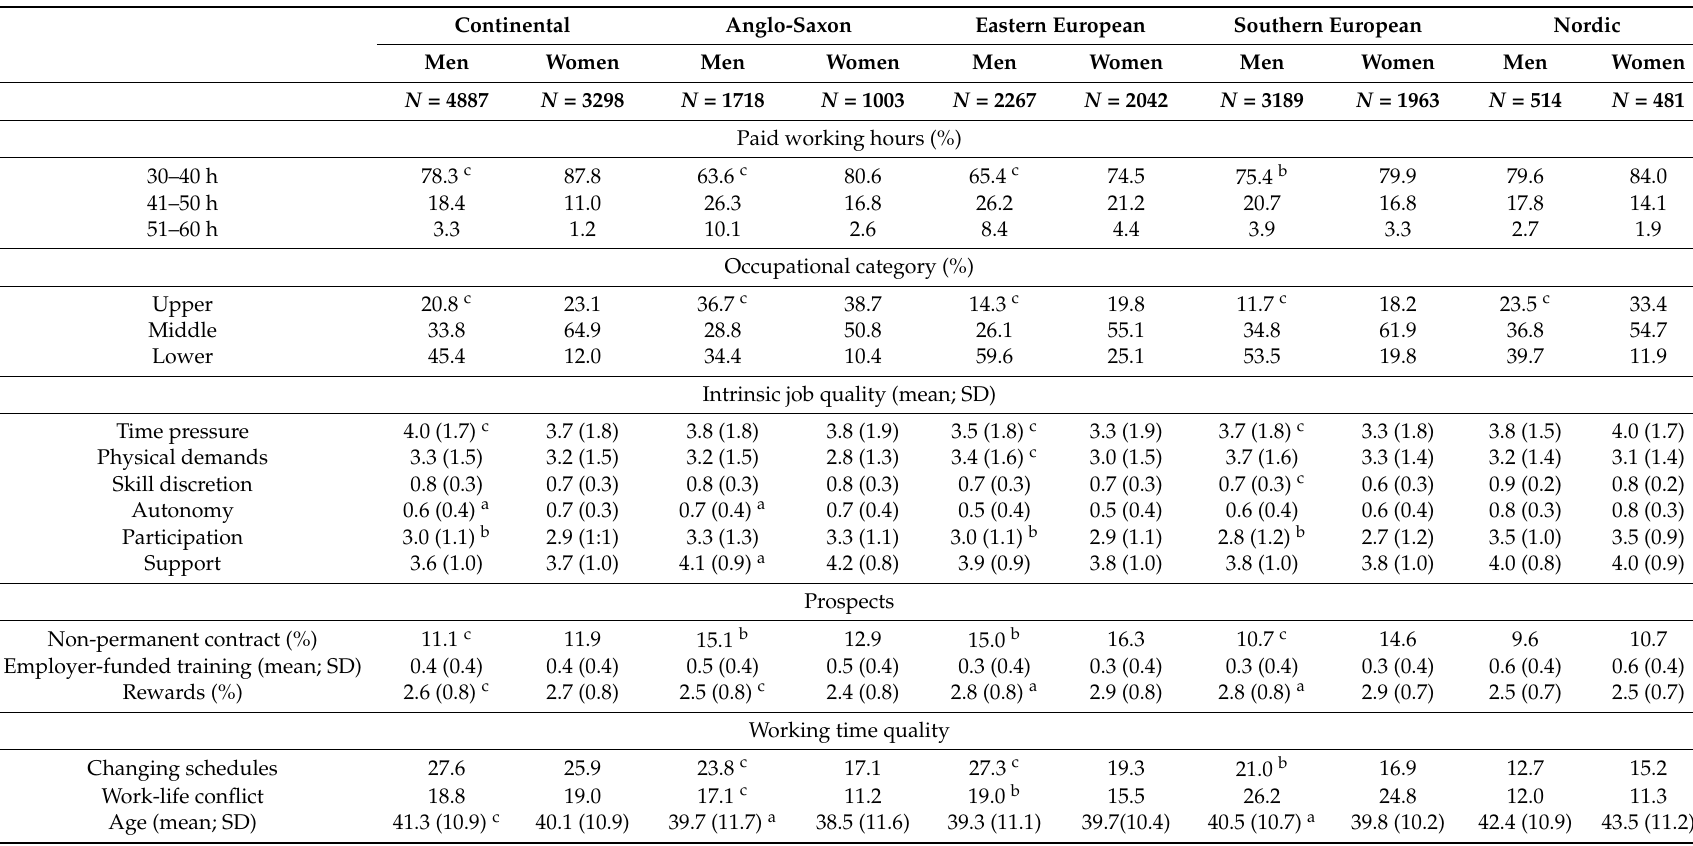
Table 1. General description of the population by sex and country group. Employees working 30–60 h a week. (%). 5th European Working Conditions Survey, 2010. Continental Anglo-Saxon Eastern European Southern European Nordic Men Women Men